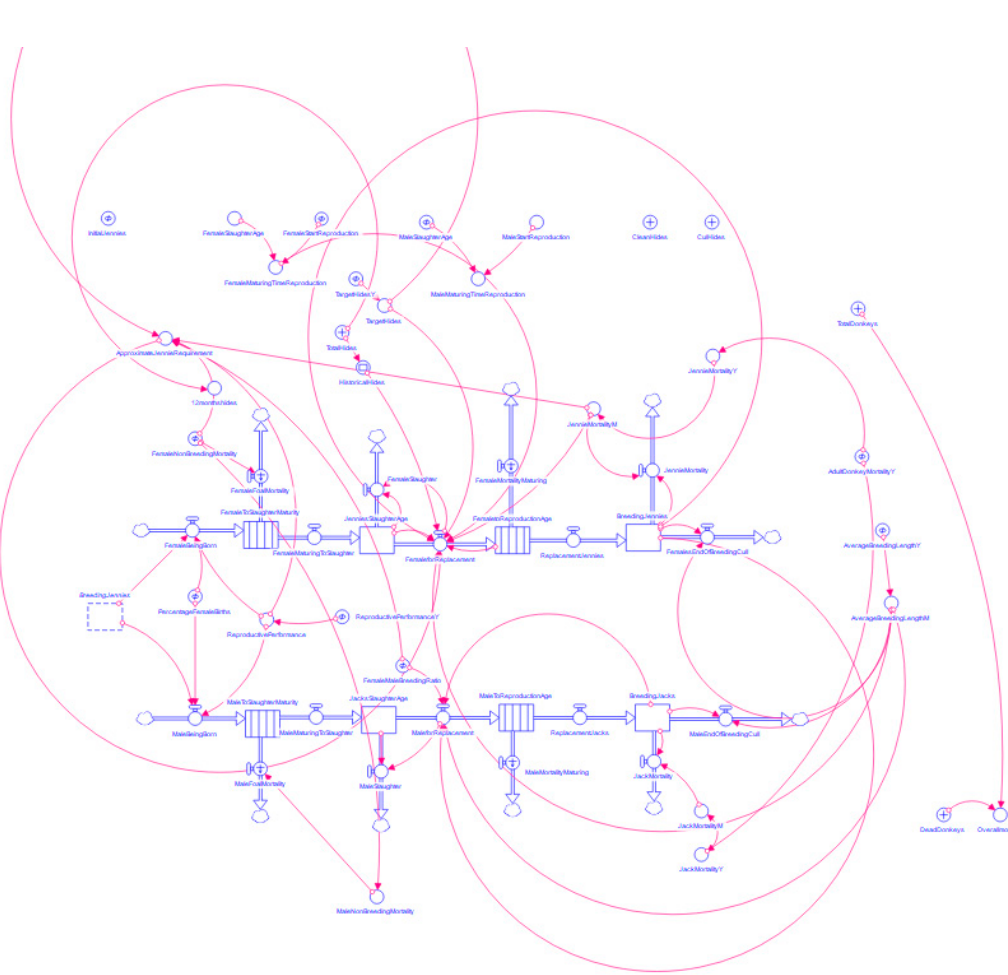
Figure A2. Farming system model: Stock and flow Figure D1. Farming system model: Stock and flow diagram.